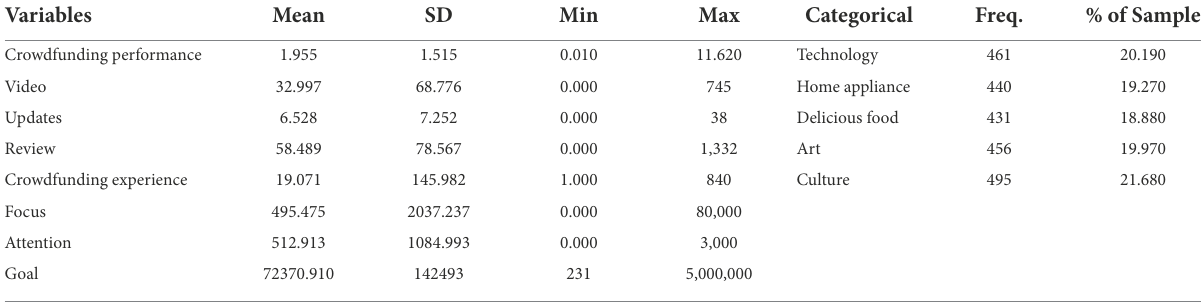
TABLE 1 Descriptive statistical analysis of key